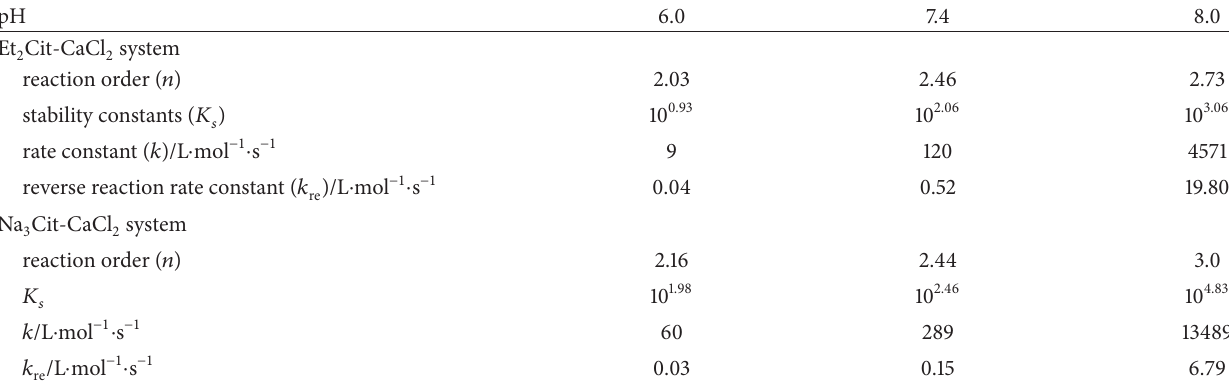
Cit and Na Cit with Ca 2+ ions. 2 3